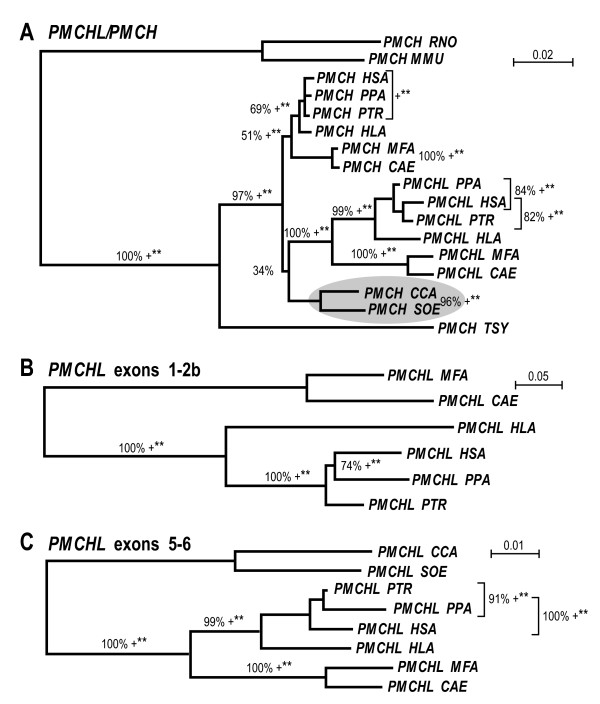
Phylogenetic analyses of the PMCH and PMCHL genes. Phylogenetic analyses of (A) the alignable PMCH and PMCHL sequences, of (B) the region encompassing exon 1 to exon 2b of PMCHL, and of (C) the region encompassing exon 5 to exon 6 of PMCHL. All three unrooted trees were obtained using a neighbour-joining (NJ) method. Branches also found by maximum likelihood (G option) and parsimony are indicated with ** (p < 0.01) and +, respectively. Grey oval indicates unresolved localization of the platyrrhine PMCH branch. Mus musculus (MMU) and Rattus norvegicus (RNO) are used as outgroups in (A). GenBank accession numbers and positions in http://www.ensembl.org are as indicated in Figure 2, and the following: PMCH PPA [GenBank:EU916247], PMCH PTR [GenBank:EU916248], PMCH HLA [GenBank:EU916249], PMCH MFA [GenBank:EU916243], PMCH CAE [GenBank:EU916244], PMCH CCA [GenBank:EU916246], PMCH SOE [GenBank:EU916245], PMCH TSY [GenBank:EU916242], PMCH RNO [GenBank:NM012625], PMCH MMU [GenBank:NT039500], PMCHL1 HSA [GenBank:AY028318, GenBank: AY028319], PMCHL2 HSA [GenBank:AY028320, GenBank:AY028321], PMCHL1 PTR [GenBank:EF043265].